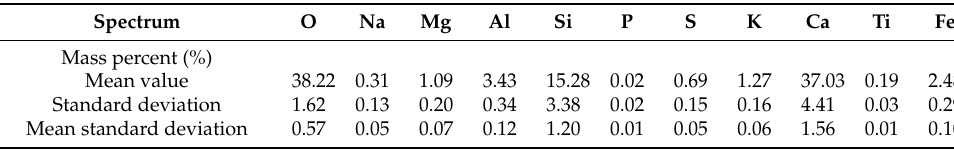
Table 5. Chemical properties of RCA